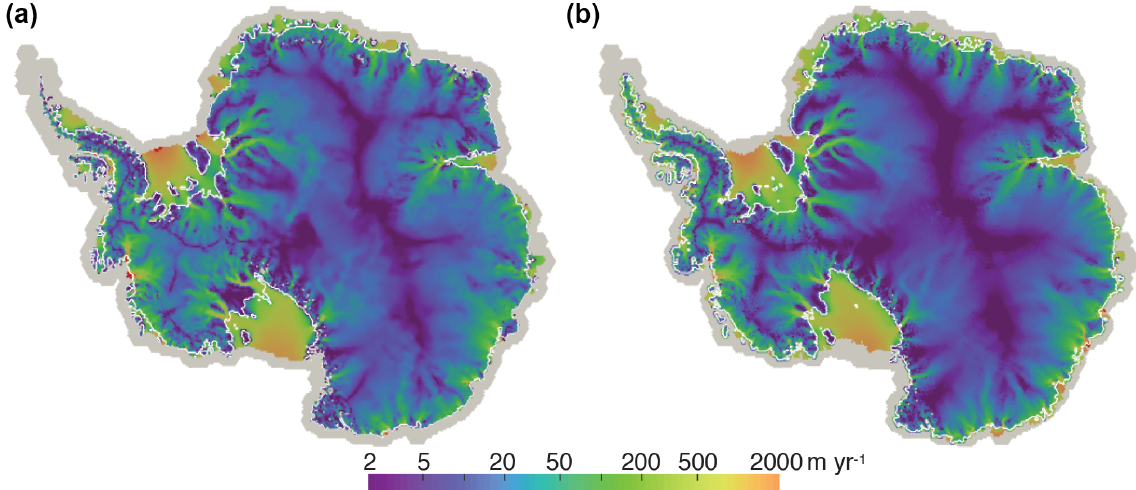
Figure 5. Demonstration of eigencalving capability using a 20km resolution simulation of Antarctica (too coarse resolution for scientific validity but sufficient for demonstrating model capabilities). (a) Modeled ice extent and surface speed after optimization. The white contour line in each plot is the grounding line. Areas colored red exceed the maximum speed shown in the color bar. Gray areas are ice-free regions of the computational domain. (b) Modeled ice extent and surface speed after 1000 years with evolving velocity, geometry, and temperature and active eigencalving, plotted as in (a)